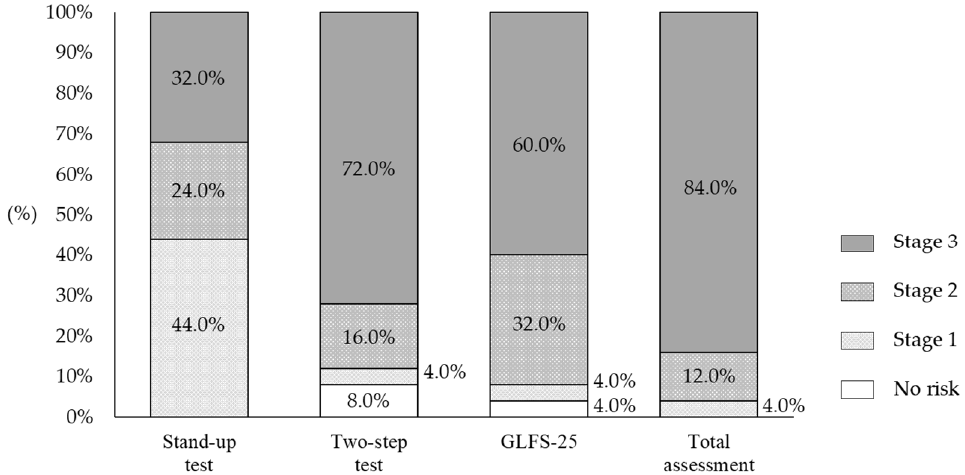
Figure 1. Distribution of risk levels for locomotive syndrome based on the results of the stand-up test, two-step test, and GLFS-25.